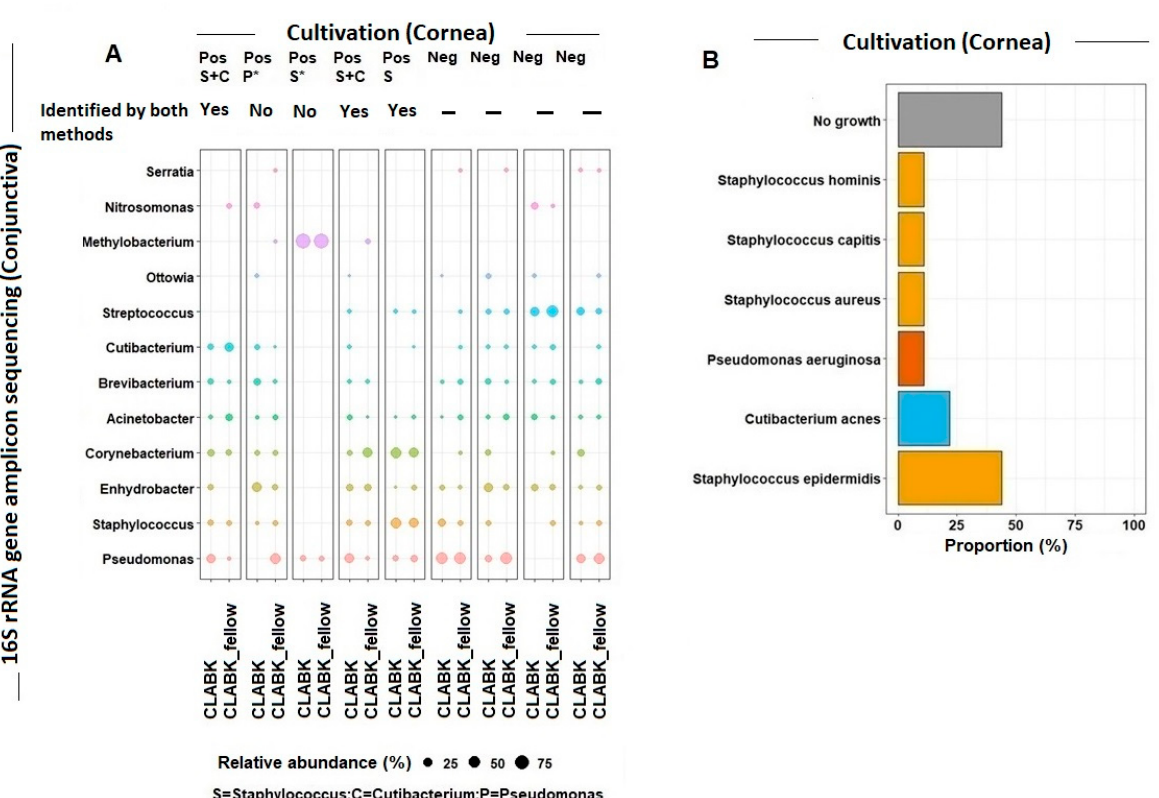
Figure 3. ( A ) 16S rRNA gene amplicon sequencing versus cultivation of the ocular surface microbiota. For contact lens users with bacterial keratitis (i.e., CLABK = eye with bacterial keratitis; CLABK_fellow = eye without bacterial keratitis), the relative abundance for the most common genera identified in the conjunctiva using 16S rRNA gene amplicon sequencing was compared with the cultivation results from the sampling of the corneal infiltrates. Five cultivations were positive for growth (Pos), defined as ≥ one bacterial species, and four cultivations were without growth (Neg). The potential bacterial pathogens of the cornea were identified at the genus level as Staphylococcus (S), Cutibacterium (C), and Pseudomonas (P). For four out of the five positive cultures, the same bacteria at the genus level were detected in the CLABK samples with 16S rRNA gene amplicon sequencing and by cultivation. (The relative abundance for Staphylococcus was ≤ 1% in one CLABK sample and therefore not shown in the figure (marked with *)). Pseudomonas was identified by cultivation in one patient; however, the relative abundance was 0% in the CLABK sample using 16S rRNA gene amplicon sequencing. Minimum relative abundance for the shown genera was 1%. ( B ) Cultivation results of the corneal infiltrates in the CLABK samples. Six bacterial species were identified, and Staphylococcus epidermidis was the most frequently cultivated potential pathogen with growth in four out of five patients (80%). One to three bacterial species were cultivated per patient, while cultivations for four out of nine patients (44%) showed no